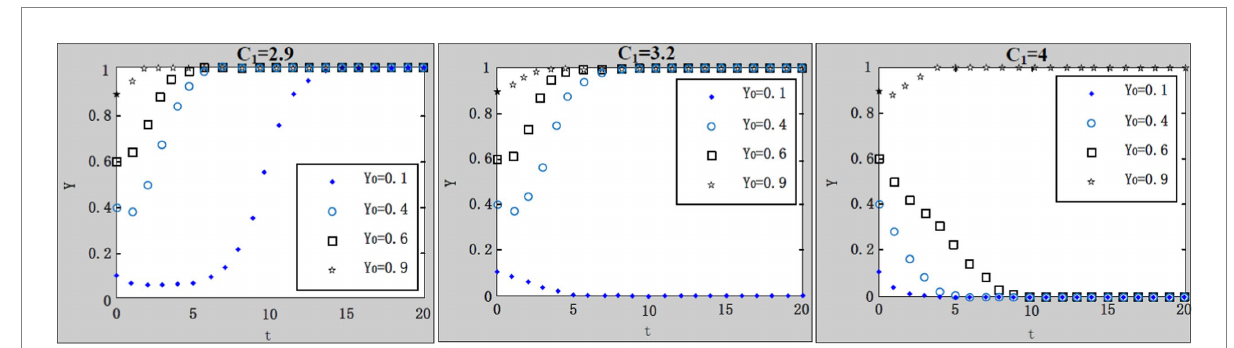
FIGURE 8 Influence of local government’s ex ante supervision cost on system evolution.